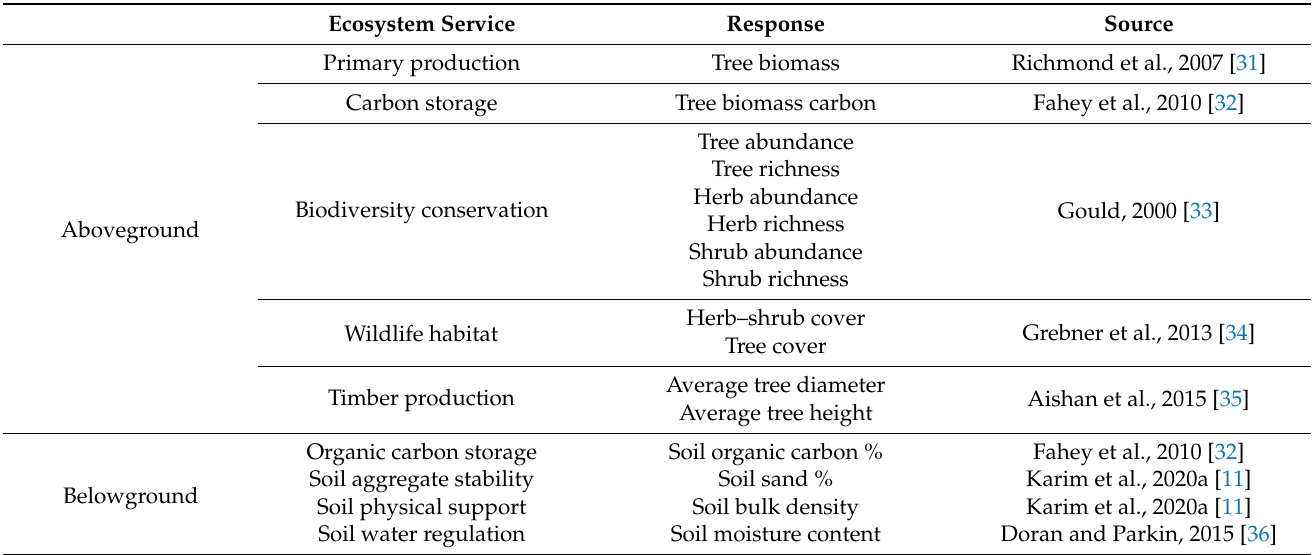
Table 1. List of responses associated with key ecosystem services in our study based on previous